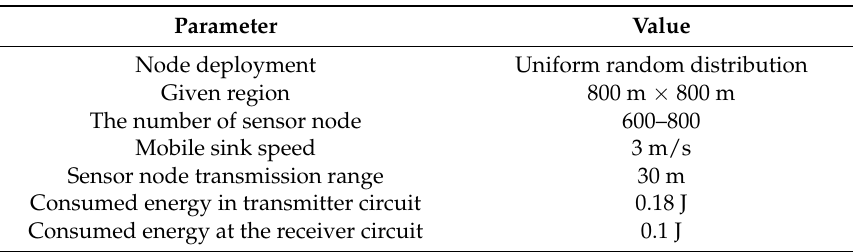
Table 2. Simulation